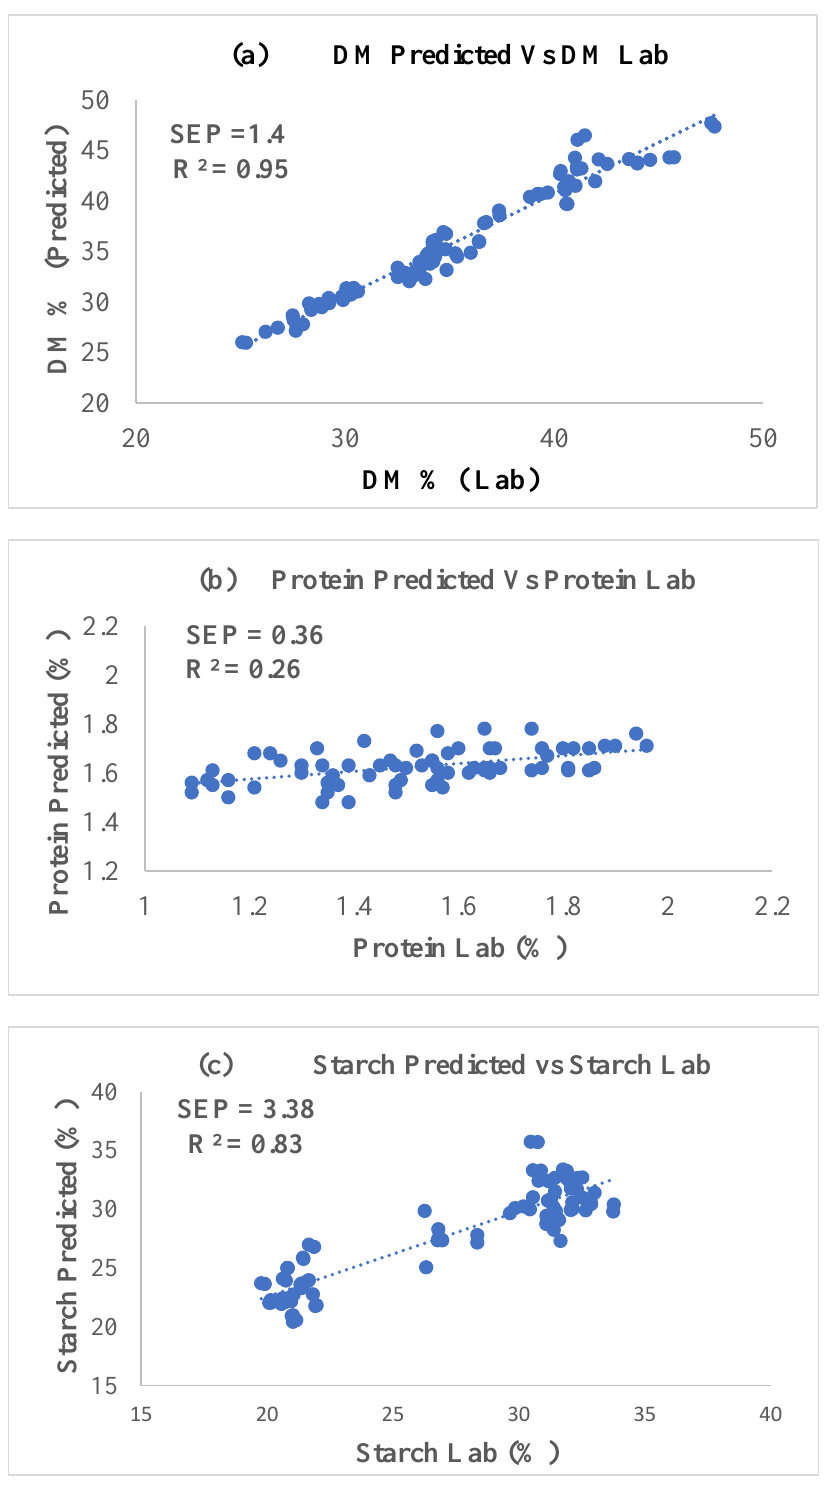
Figure 5. ( a ) Scatter plot of predicted dry matter vs. actual dry matter; ( b ) predicted protein vs. actual protein content; ( c ) predicted starch content vs. actual starch content for blended yam samples. SEP : standard error of prediction.